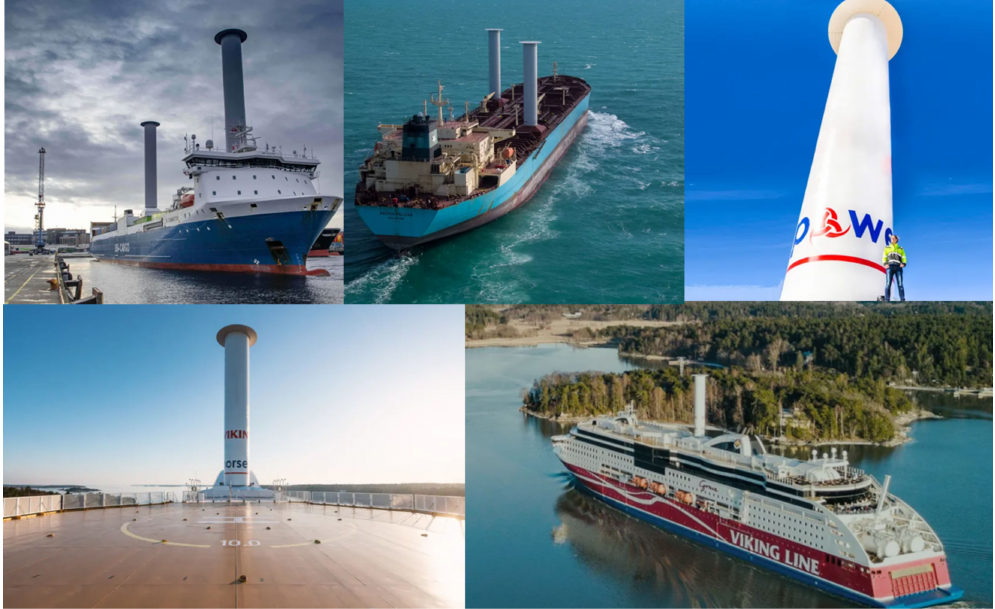
Figure 7. Examples of vessels with Flettner rotors installed, different vessel types: RoRo vessel, tanker and ferry, Image courtesy: Norsepower Oy Ltd.